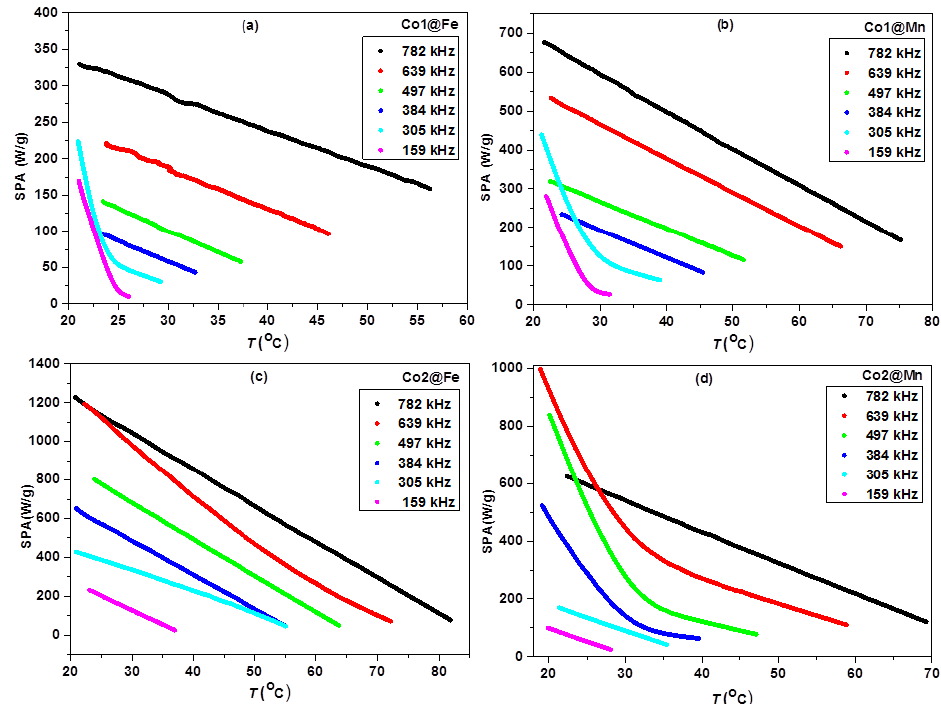
Figure 4. SPA vs. T at different frequencies for samples Co1@Fe ( a ), Co1@Mn ( b ), Co2@Fe ( c ) and Co2@Mn ( d ).